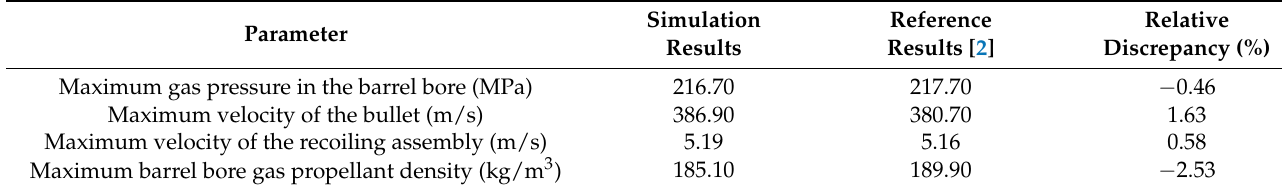
Table 3. Comparison of the results of preliminary verification